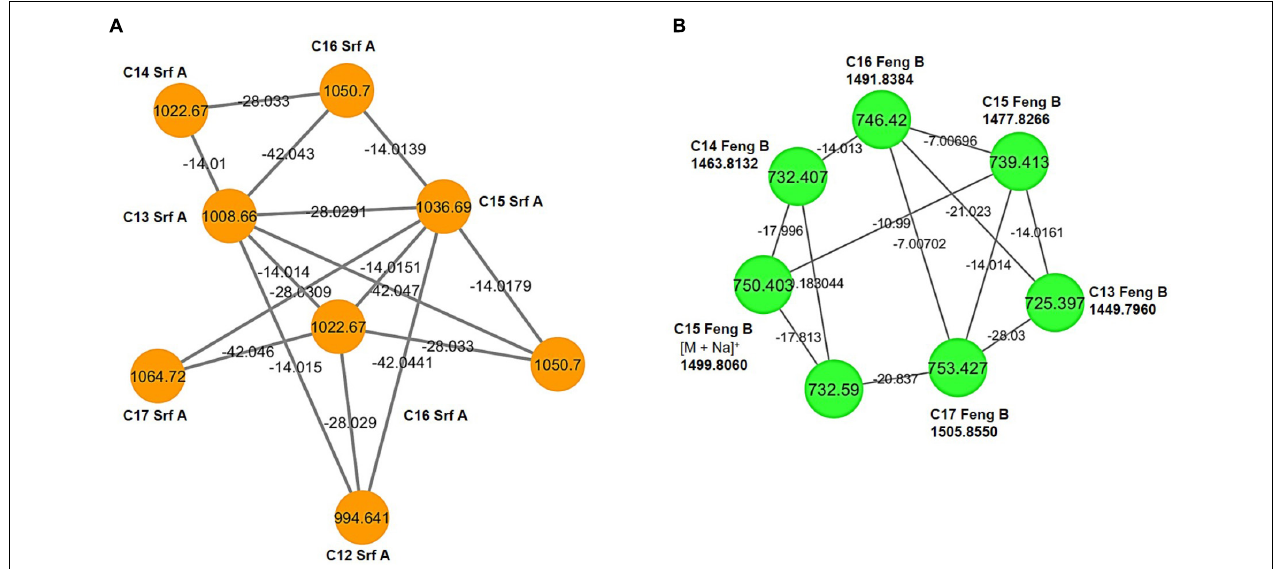
FIGURE 4 | Molecular networks of Bacillus sp. M21a extracts. (A) Surfactin A homologs ([M + H] + ; orange), the m/z differences of 14.01, 28.03, and 42.04 indicate molecules with different lengths of fatty acid chains within this cluster. (B) Fengycin B cluster from double charged precursor ions m/z ([M + 2H] 2 + ; green). Nodes represent the precursor ion and bridges indicate the mass difference between individuals nodes. Labels at the nodes name the respective dereplicated molecule. Srf, surfactin; Feng, fengycin, the number indicates the length of the lipid